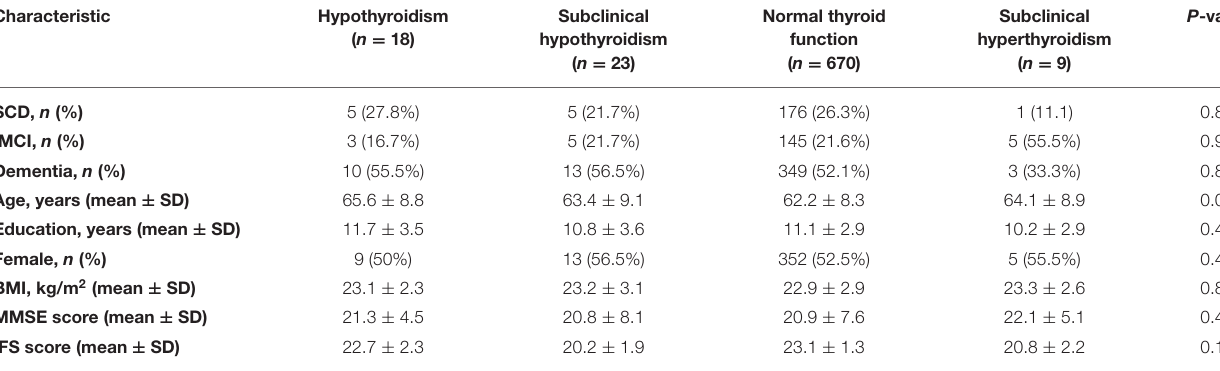
TABLE 2 | Demographic, clinical, and cognitive characteristics of participants with normal thyroid function and thyroid dysfunction.